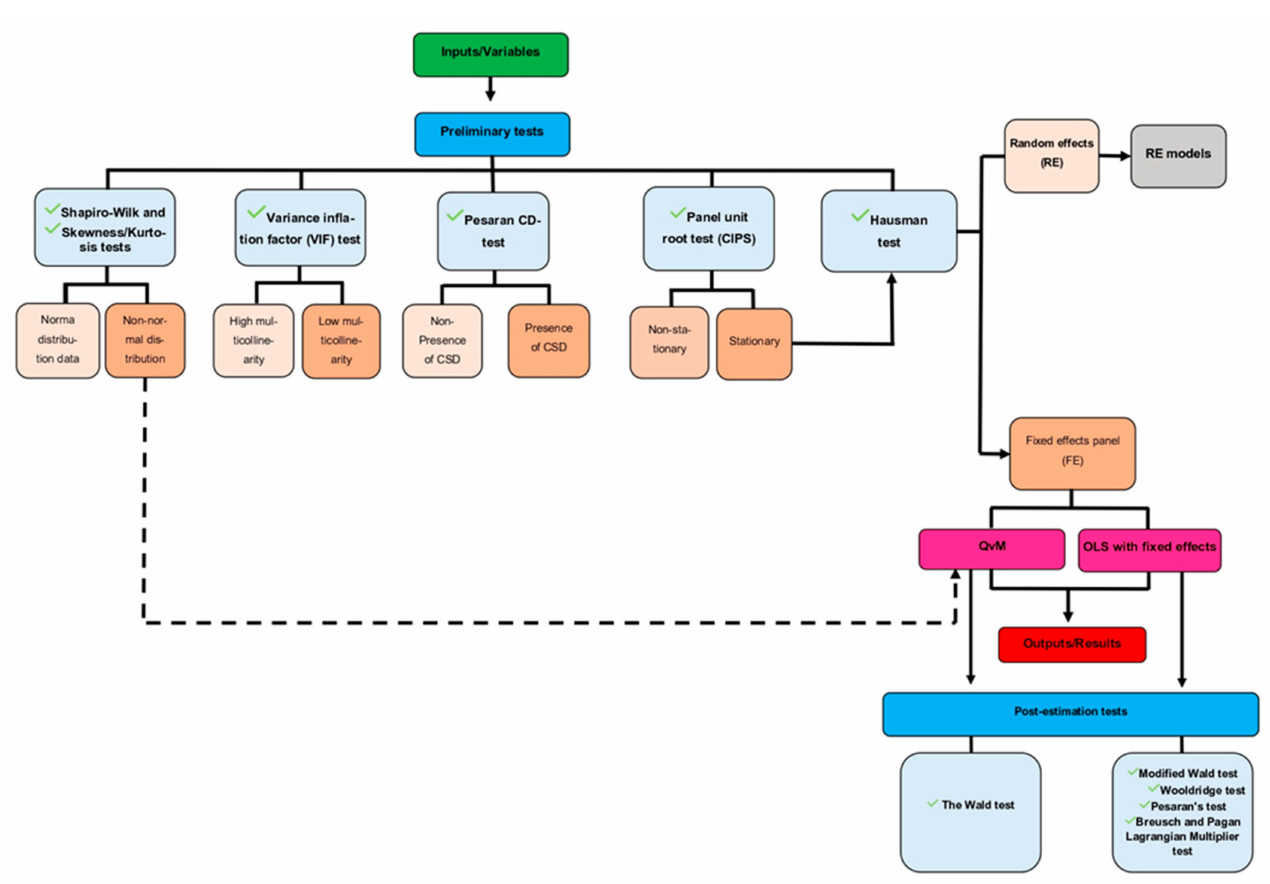
Figure 1. Methodological strategy. The authors created this